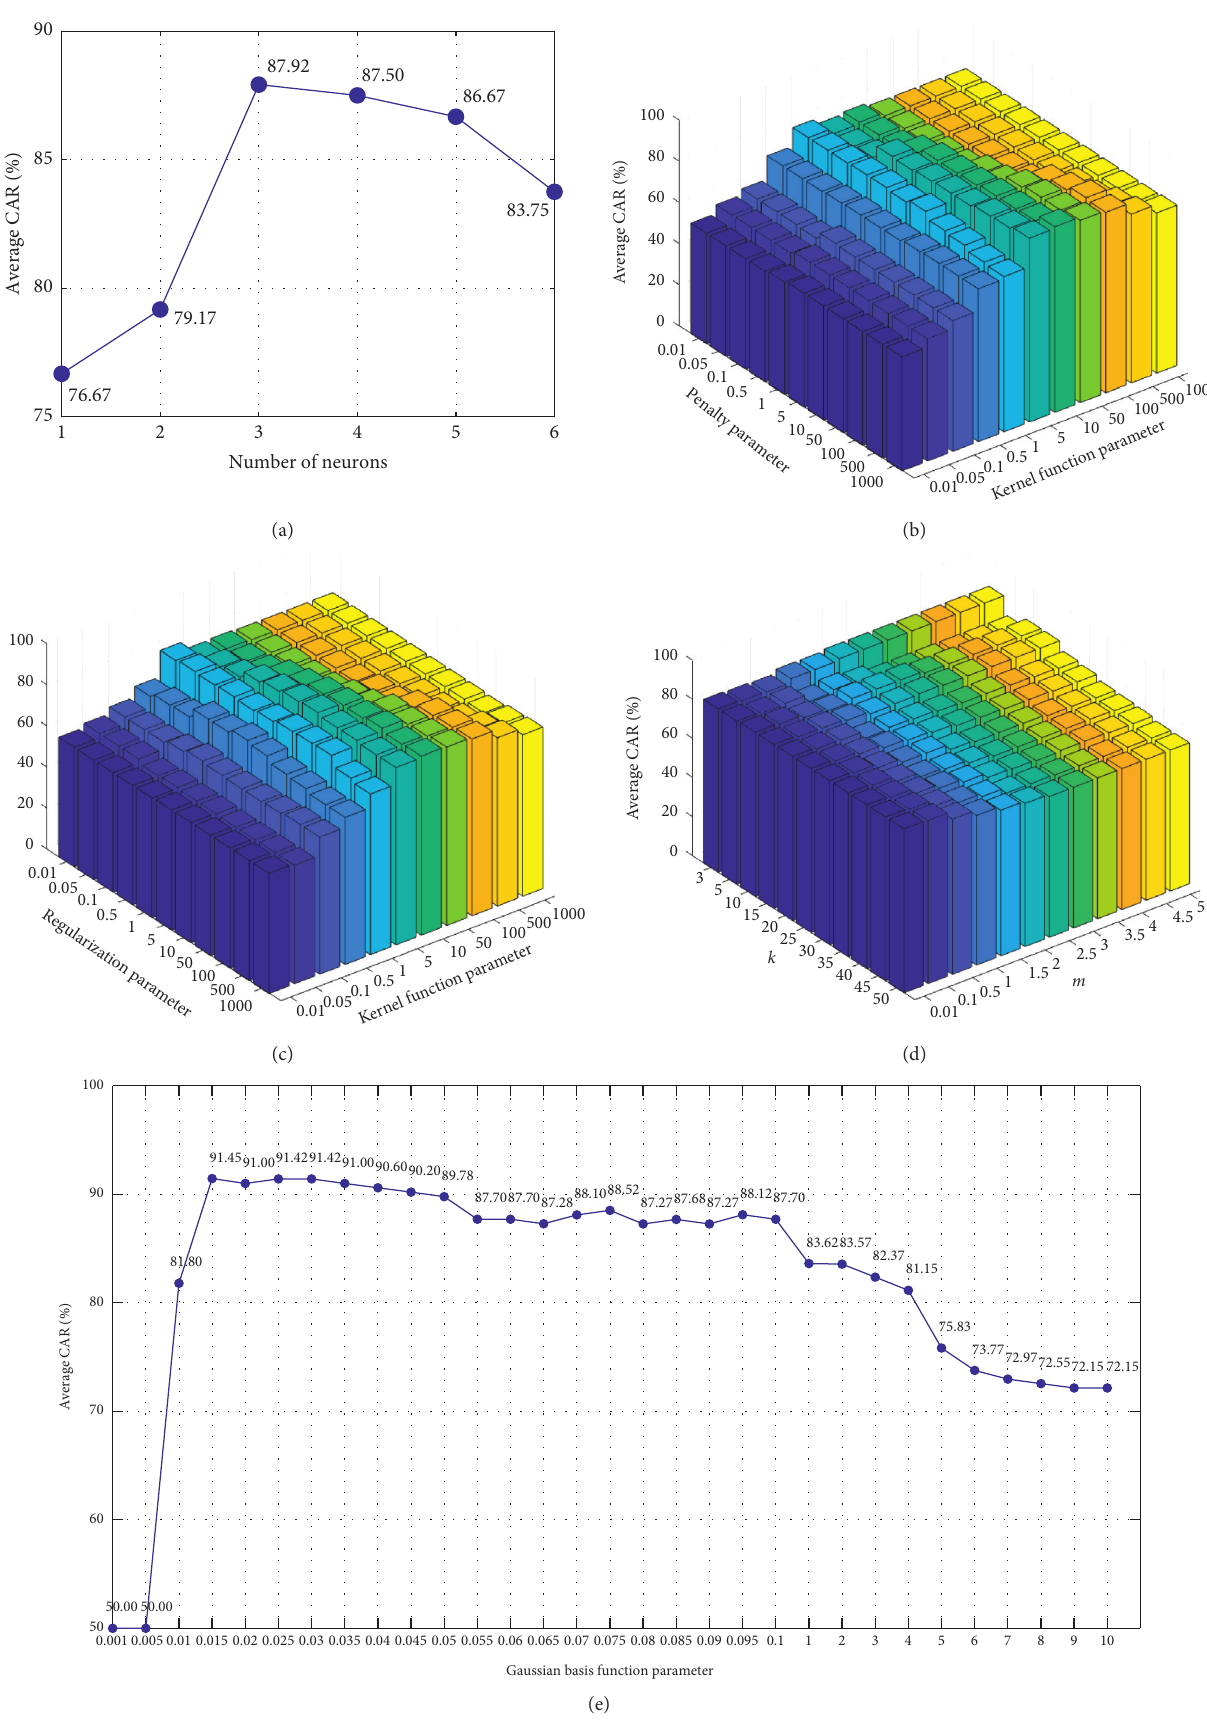
Figure 3: Model performance analysis: (a) ANN, (b) SVM, (c) LSSVM, (d) FKNN, and (e)